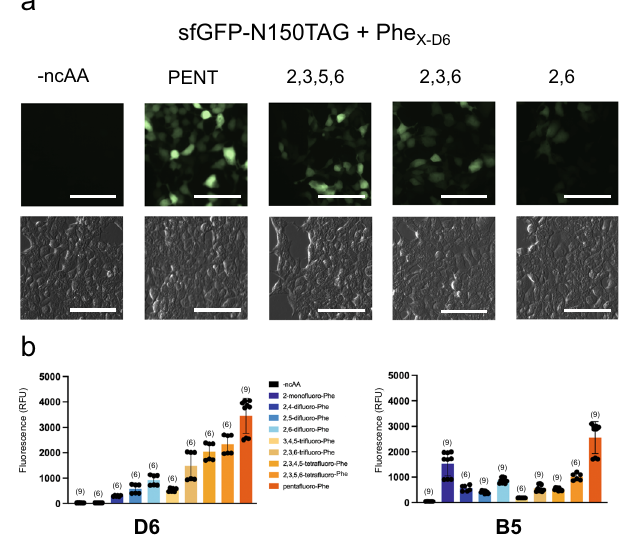
Fig. 5 | Function ofPhe X synthetases in HEKT cells. a Micrographs of HEKT cells co-transfected with GFP_N150TAG and Phe X-D6 in the presence or absence of the given amino acid, GFP (top) and bright fi eld (bottom). In all cases, images were takenapproximately24haftertransfection,andtheunnaturalaminoacidwasused at a 2mM concentration. Scale bar=100 µ m. Images are representative of four individual fi elds for no amino acid and penta fl uoro-Phe, and two individual fi elds for each of the remaining amino acids. b Lysate GFP fl uorescence for a range of fl uorinated phenylalanine residues. N values are listed for a number of readings, with bar height indicating mean values±standard